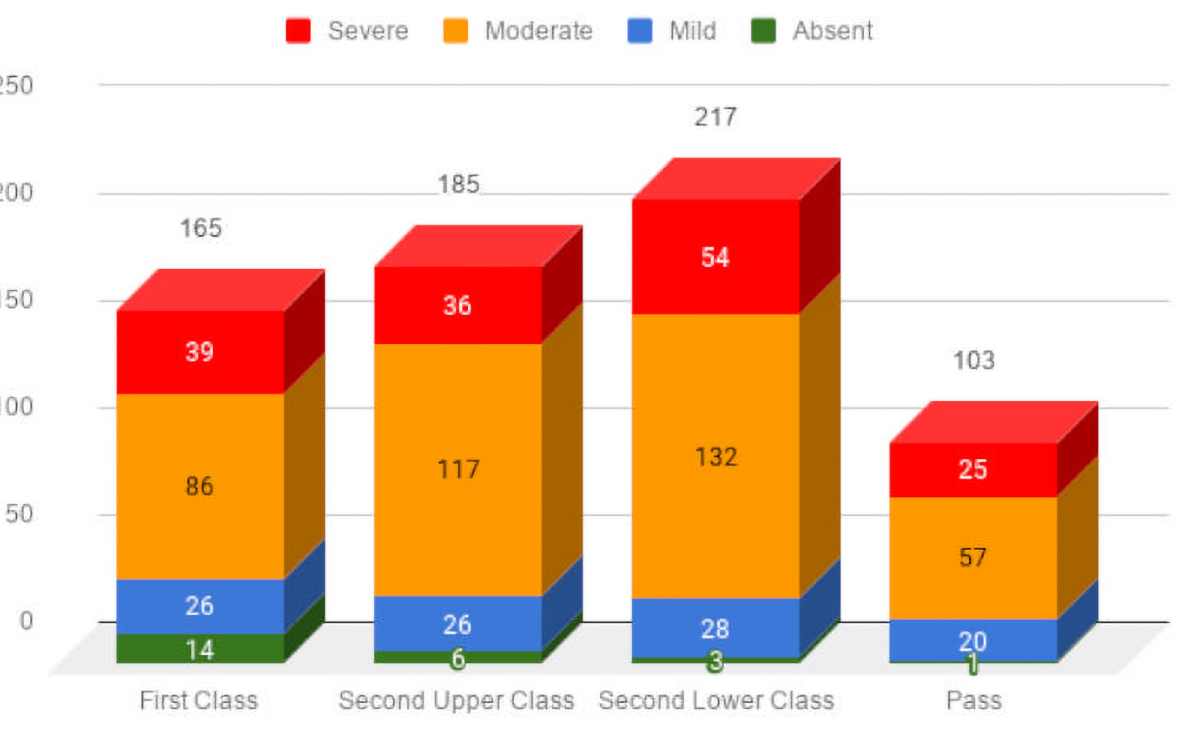
Fig 4. Visualisation of levels of nomophobia and academic